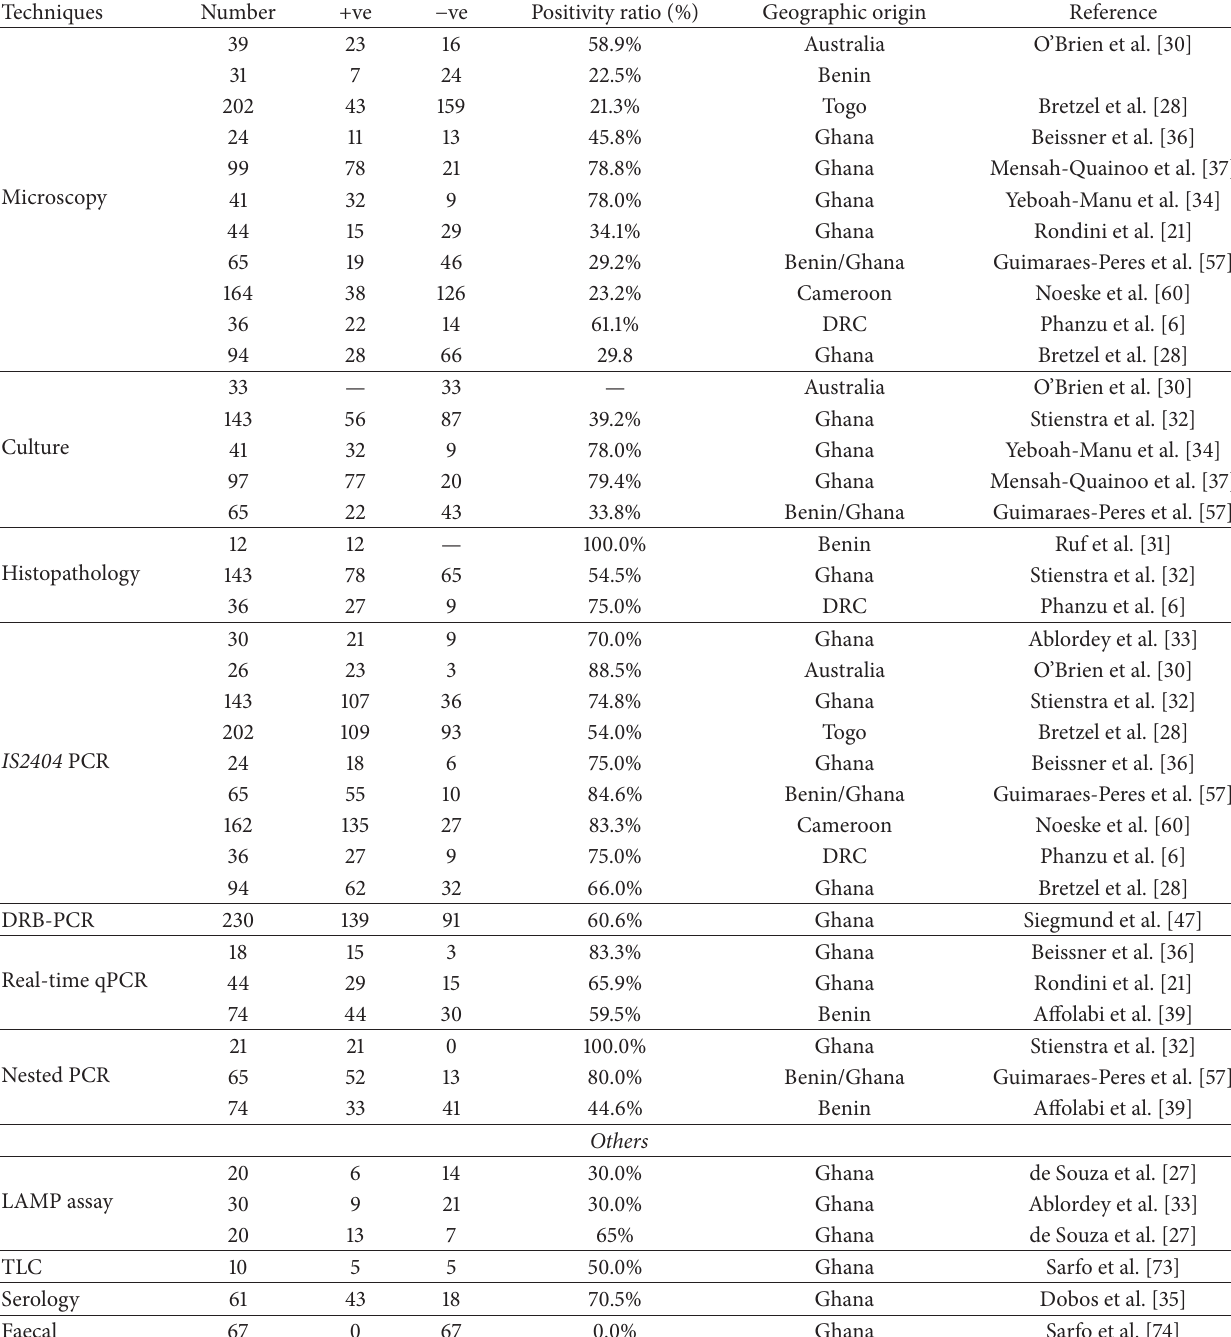
Table 2: Summary of various diagnostic techniques for